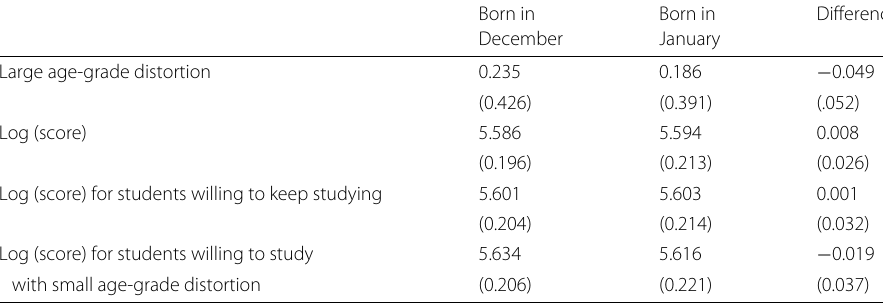
Table 2 Descriptive statistics: selected sample